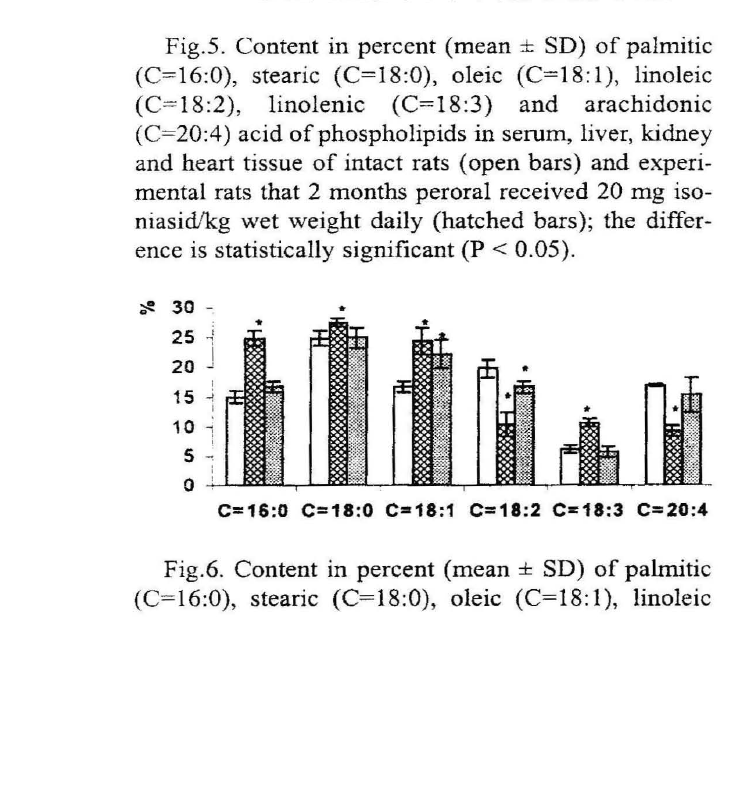
Fig.5. Content in percent (mean ± SD) of palmitic